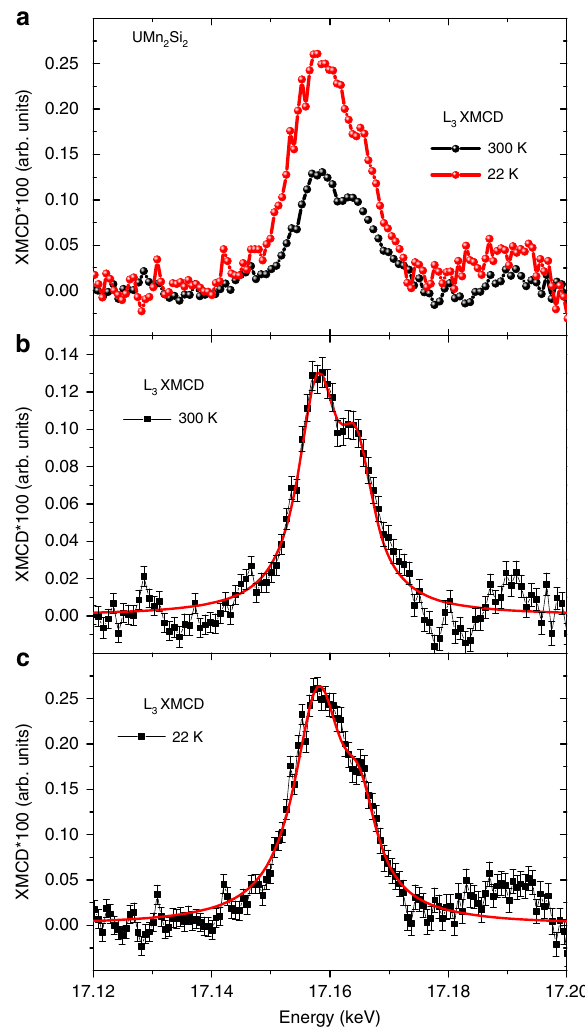
Fig. 2 Temperature dependence of the X-ray Magnetic Circular Dichroism (XMCD) contributions. a XMCD uranium L 3 edge for the UMn 2 Si 2 compound at temperatures of 300 K and 22 K. The experimental XMCD data with the respective statistical error bars for T = 300 K and T = 22 K are shown in b , c . The red lines are guides for the eyes to facilitate the visualization of the disproportional changes on the amplitude of each peak (dipolar and quadrupolar) when the temperature is reduced from 300 K to 22 K. Experimental error bars for each energy point are de fi ned as the standard deviation (s.d.) between the multiple averaged spectra the uranium XMCD signal is overall enhanced at low tempera-